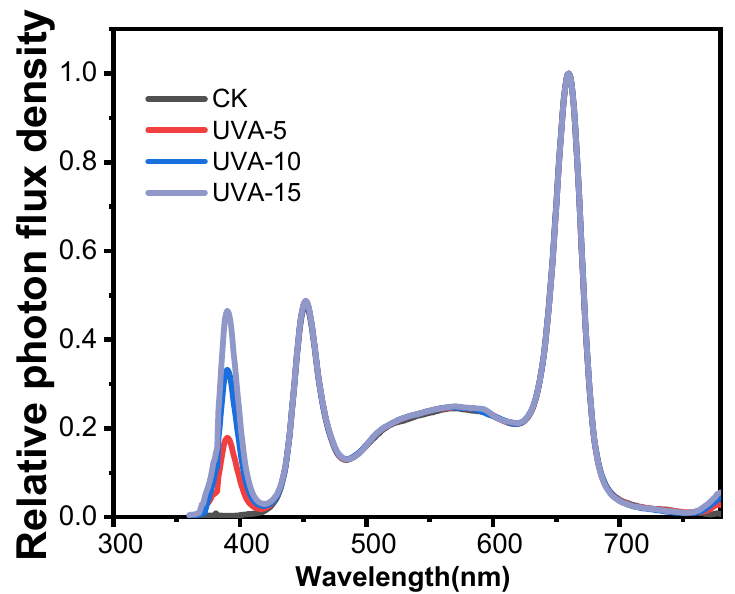
Figure 1. Spectral composition in the four treatments.